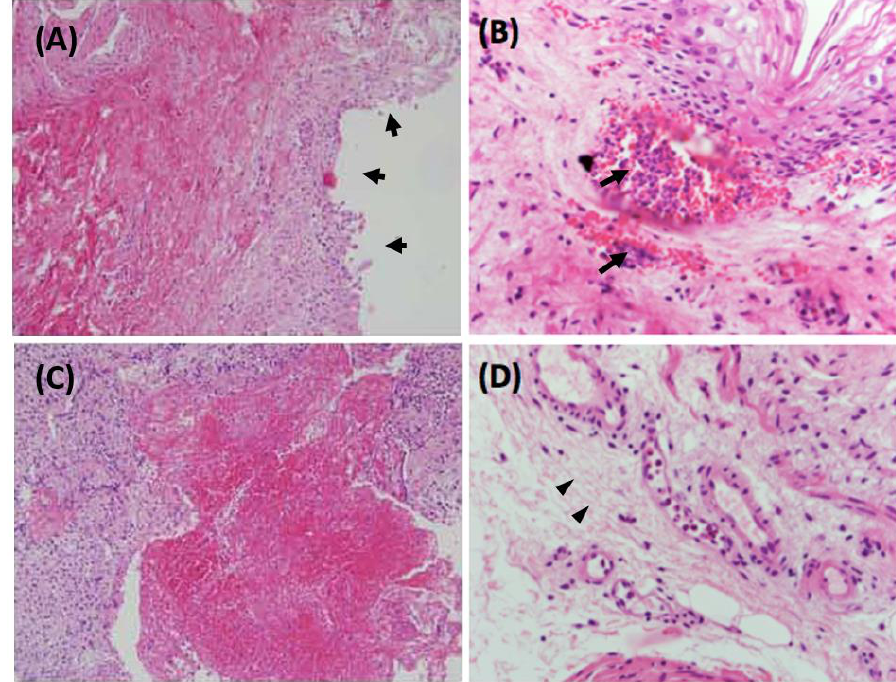
Figure 1. Histology of the urinary bladder in ketamine-induced cystitis (KC) patients stained with hematoxylin and eosin showed ( A ) denuded bladder mucosa (short arrows), ( B ) infiltration of neutrophils and eosinophils in the bladder stroma, and accumulation of intravascular eosinophils (arrows), ( C ) ulceration of the urothelium and ( D ) collagen deposition in the submucosal layer (arrowheads). ( A ) and ( C ) at 200 × that were modified from [17]; ( B ) and ( D ) at 400× that were modified from [18].